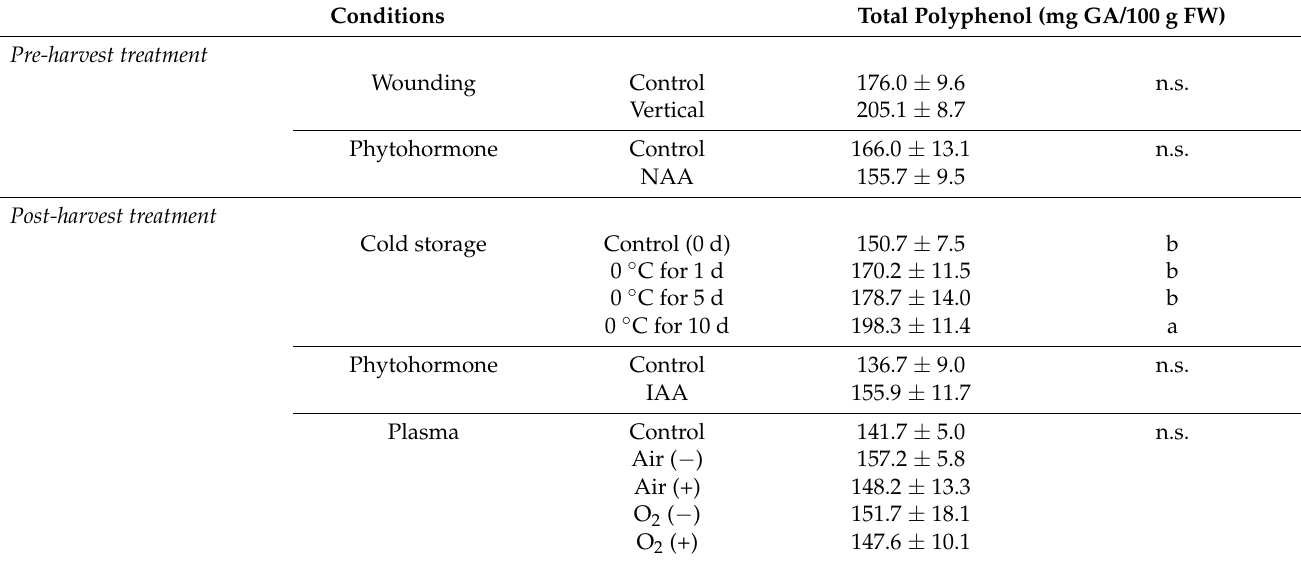
Table 1. Total polyphenol contents in strawberry fruits under various pre- and post-harvest